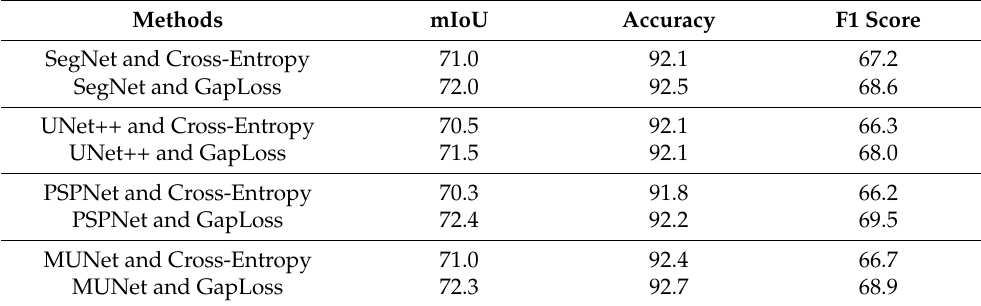
Table 3. The results of SegNet and UNet++ on Aerial Image Segmentation Dataset.